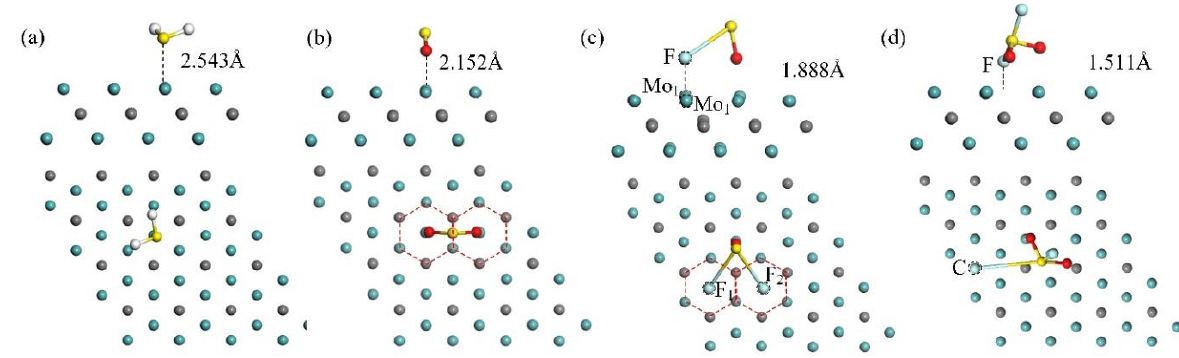
Figure 2. most stable conformation of H 2 S ( a ), SO 2 ( b ), SOF 2 ( c ) and SO 2 F 2 ( d ) systems.